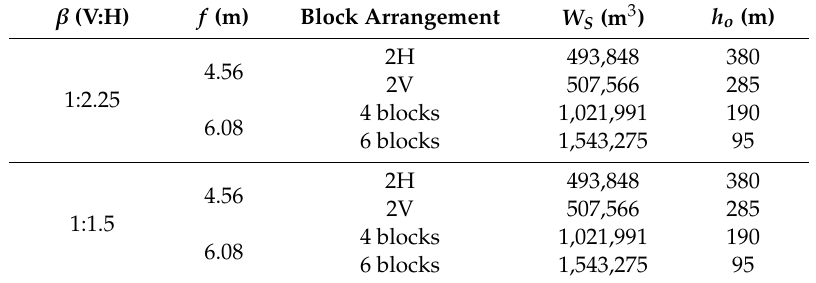
Table 4. Summary of input slide and dam parameters used in the experiments (prototype